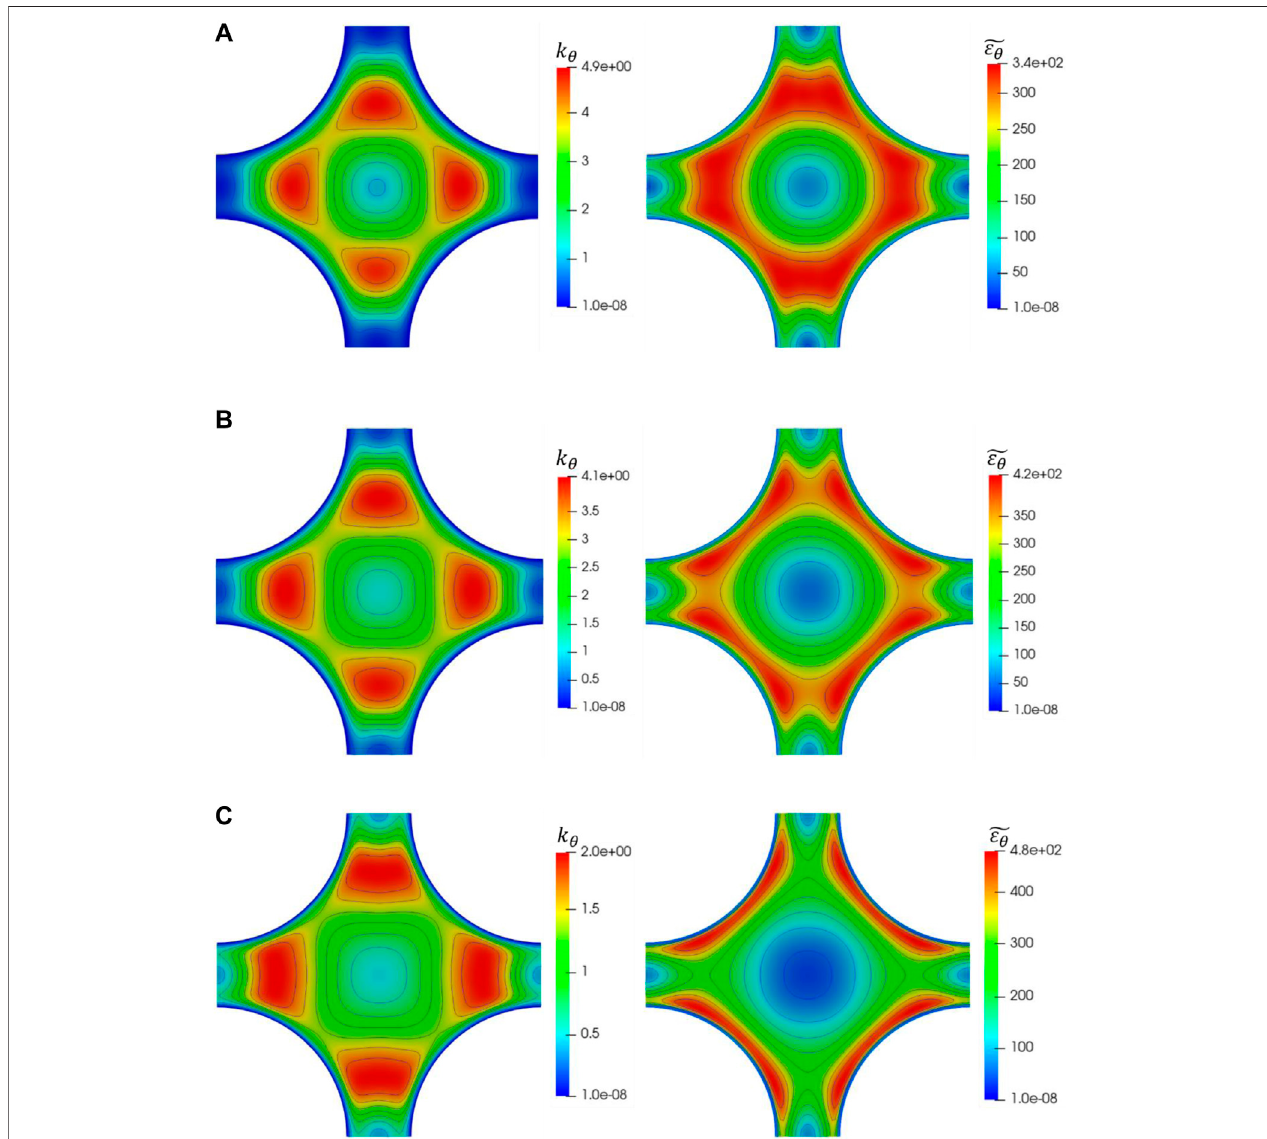
FIGURE 10 | Schematic diagram of average temperature fl uctuaion (left) and its isotropic dissipation (right) on a slice for square lattice X = 1.25. (A) Pe = 1000; (B) Pe = 2000; (C) Pe = 4000.